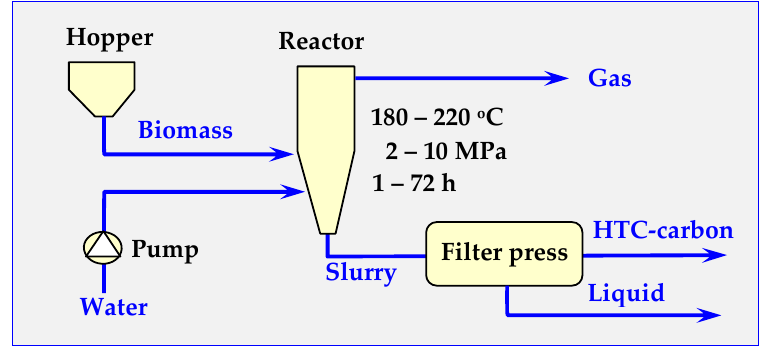
Figure 22. Scheme of the Hydrothermal carbonization process (HTC) [167,168].